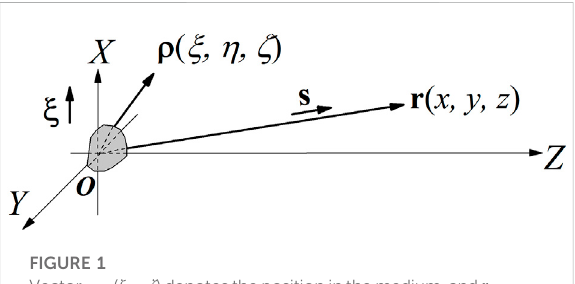
FIGURE 1 Vector ρ =( ξ , η , ζ )denotesthepositioninthemedium,and r = r s = ( x, y, z ) denotes the position in the far- fi eld. ξ is the unit vector along the X -axis, and s is the unit vector along with r